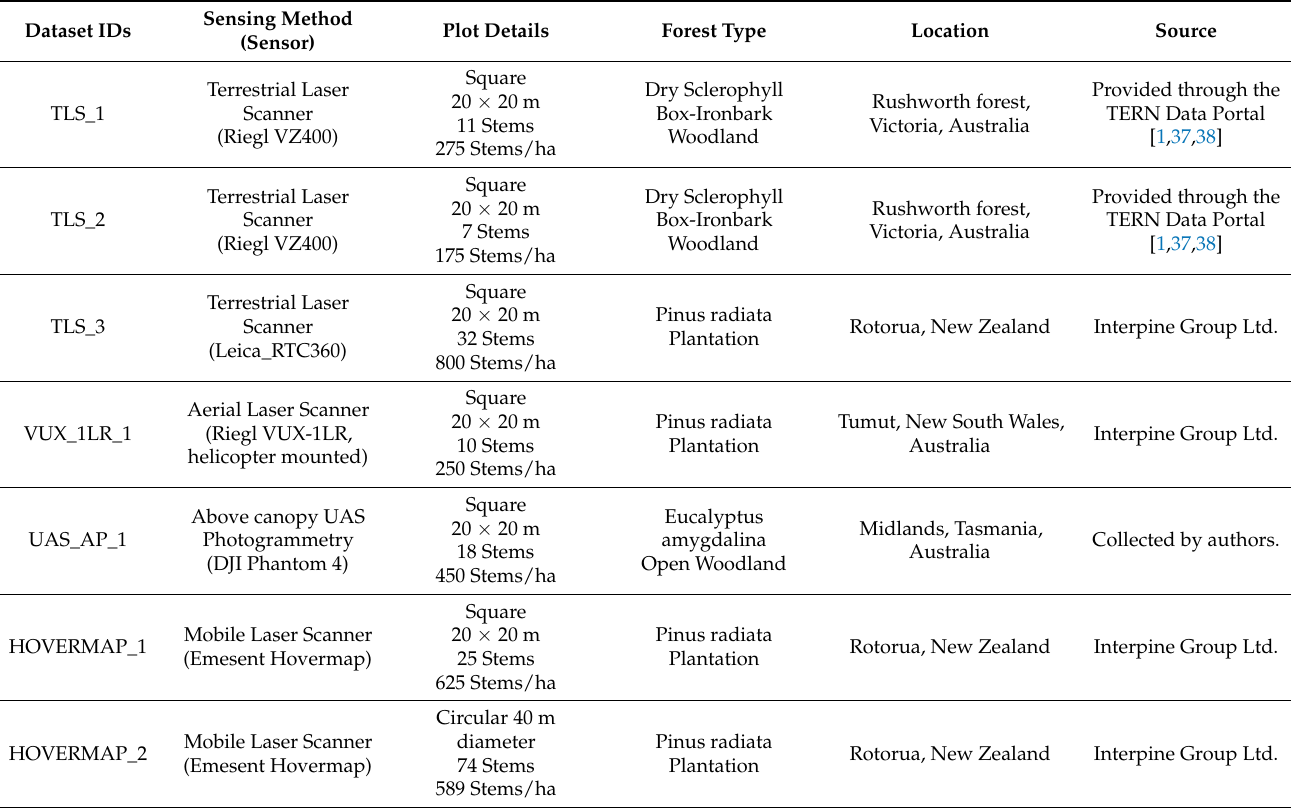
Table 1. Description of manually labeled point cloud datasets, their dominant plant species, and plot dimensions. Counted stems were >100 mm diameter at breast height. Stem counts were automatically extracted and not manually